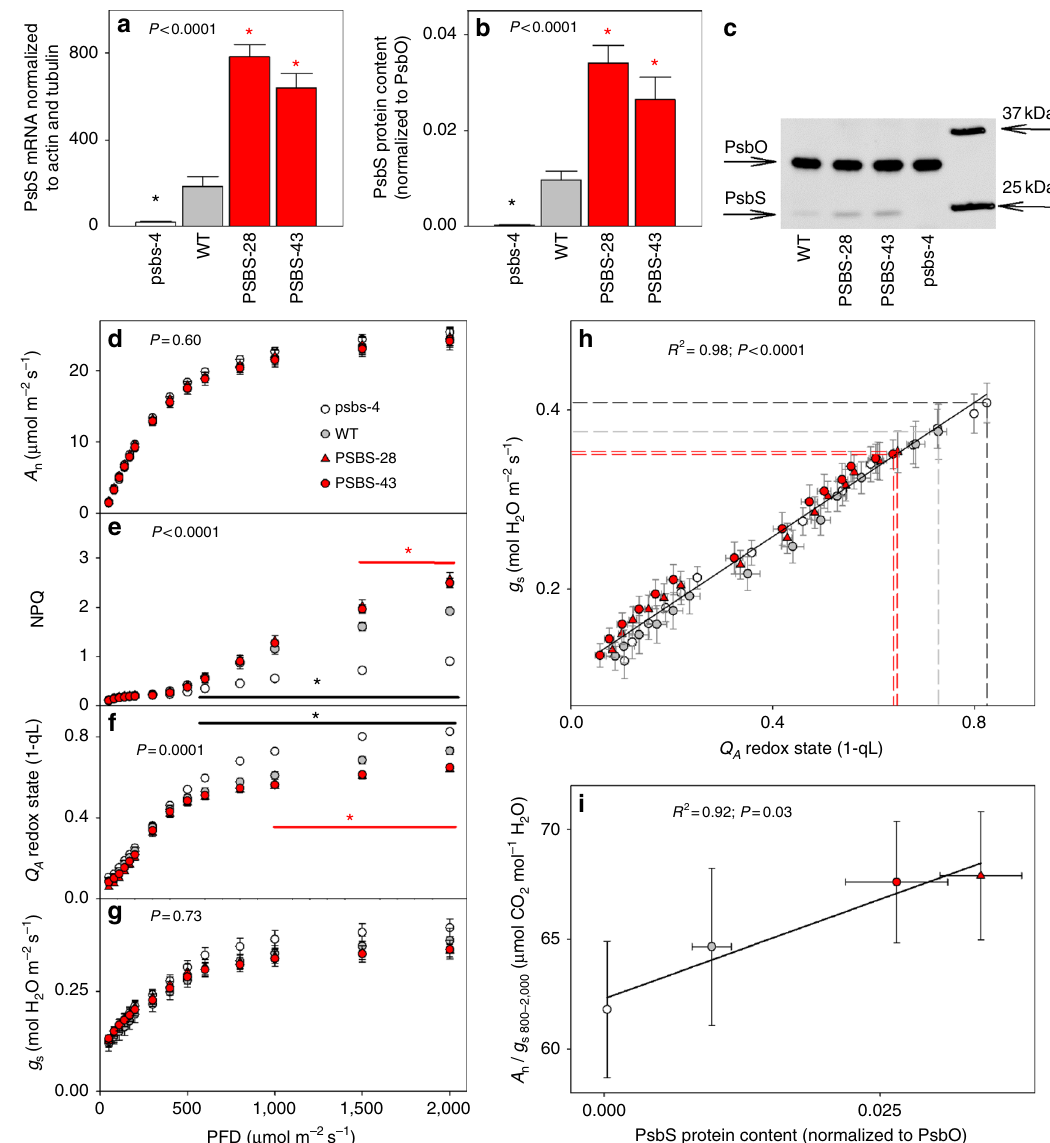
Fig. 1 Photosynthesis and water-use ef fi ciency in Nicotiana tabacum plants with modi fi ed PsbS levels. a PsbS mRNA levels normalized to actin and tubulin sampled from fully expanded leaves of psbs-4, PSBS-28, PSBS-43 and wild-type (WT) N . tabacum plants. b PsbS protein levels normalized to the large subunit of oxygen-evolving complex of photosystem II (PsbO), determined from densitometry on immunoblots. c Representative immunoblot for PsbS and PsbO. d Net CO 2 fi xation rate ( A n ), e NPQ, f quinone A ( Q A ) redox state, and g stomatal conductance ( g s ) as a function of incident light intensity in fully expanded leaves. h Linear correlation between Q A redox state and g s . Broken lines indicate measurements at highest light intensity. i Linear correlation between PsbS protein levels and intrinsic water-use ef fi ciency ( A n / g s ) at light intensity above 600 μ mol m − 2 s − 1 . Asterisks/lines show signi fi cant differences from WT (black for silencing, red for overexpressing lines; Dunnett ’ s two-way test; α = 0.05). Error bars indicate s.e.m. ( n = from 6 to 10 biological replicates) Stomatal pore dimensions on both abaxial and adaxial leaf differences, the redox state of Q A was signi fi cantly more oxidized surfaces were very similar between all lines (Supplementary in PSBS-28 and PSBS-43 relative to WT ( P ≤ 0.02, Dunnett ’ s two- Fig. 3b – d). In addition, all measurements of Q A redox state and g s way test; Fig. 1f) and more reduced in psbs-4 ( P ≤ 0.002, in all lines could be described by a single highly signi fi cant Dunnett ’ s two-way test; Fig. 1f). These differences in Q A redox state at high light were re fl ected in differences in stomatal positive correlation ( P < 0.0001, ANOVA; Fig. 1h), consistent conductance ( g s ; Fig. 1g). The change in g s was consistent with with a role for Q A redox state as an early determinant for stomatal altered regulation of stomatal opening rather than any changes in opening in response to light intensity 17 . Furthermore, the differences in g s associated with PsbS expression in combination stomatal or epidermal anatomy, that is, pore dimensions or stomatal density. Stomatal density was 21% (abaxial) to 23% with unchanged A n resulted in a strong correlation between intrinsic water-use ef fi ciency ( A n / g s , WUEi) and PsbS expression (adaxial) lower in psbs-4 and 18% (abaxial) lower in PSBS-43, relative to WT ( P = 0.006 for abaxial and P = 0.02 for adaxial, ( R 2 = 0.92, P = 0.03, ANOVA; Fig. 1i). ANOVA; Supplementary Fig. 3a), but unchanged in PSBS-28. | DOI: 10.1038/s41467-018-03231-x |